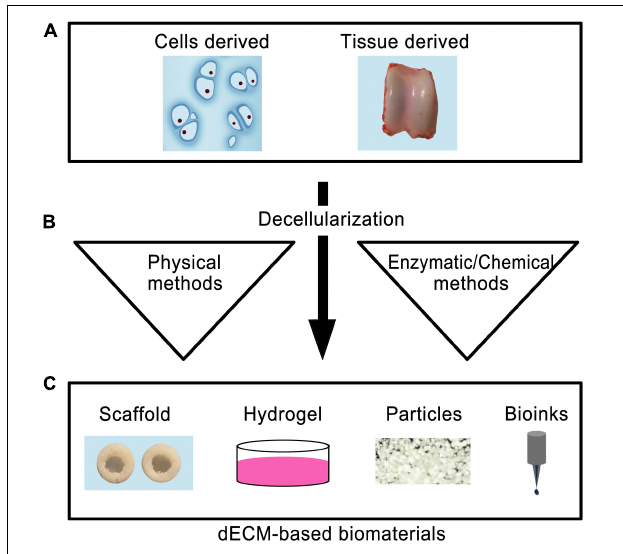
FIGURE 2 | Schematic representation of the use of decellularized biomaterials for cartilage tissue engineering. The cells or tissue-derived biomaterials (A) are subjected to decellarization through physical, enzymatic, or chemical methods (B) . The resultant dECM biomaterials can be used to produce scaffold, hydrogel, particle forms, or used as bioinks for 3D printing (C)